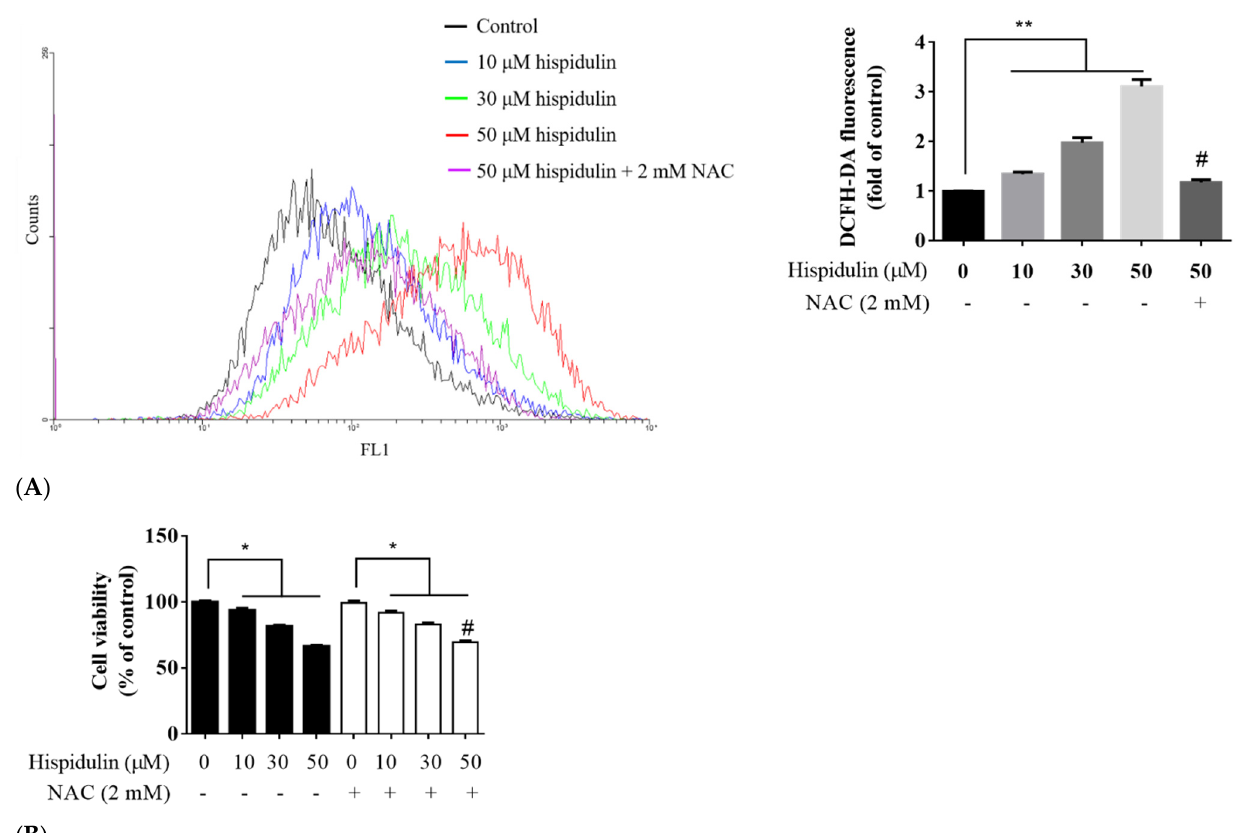
Figure 7. ( A ) Effect of hispidulin on ROS generation in A2058 cells. Detection of intracellular ROS level. A2058 cells were treated with different concentrations (0, 10, 30, and 50 µM) of hispidulin for 24 h or pretreated with 2 mM NAC for 1 h, and intracellular ROS levels were measured by flow cytometry (after staining with DCFH-DA reagent). Data are presented as fold of control and mean ± SE, with ** p < 0.01 compared with the untreated control group, and # p < 0.01 compared with the group treated with 50 µM hispidulin alone. ( B ) The effect of pretreatment with antioxidant on the death of A2058 cells induced by hispidulin. A2058 cells pretreated with 2 mM NAC for 1 h then incubated with indicated concentration of hispidulin for 24 h, or treated with hispidulin alone and determined cell viability by MTT assay. Data are presented as percentage of control and mean ± SE, with * p < 0.05 and ** p < 0.01 compared with the control group, and # p < 0.05 compared with the group treated with 50 µM hispidulin alone (n = 6).